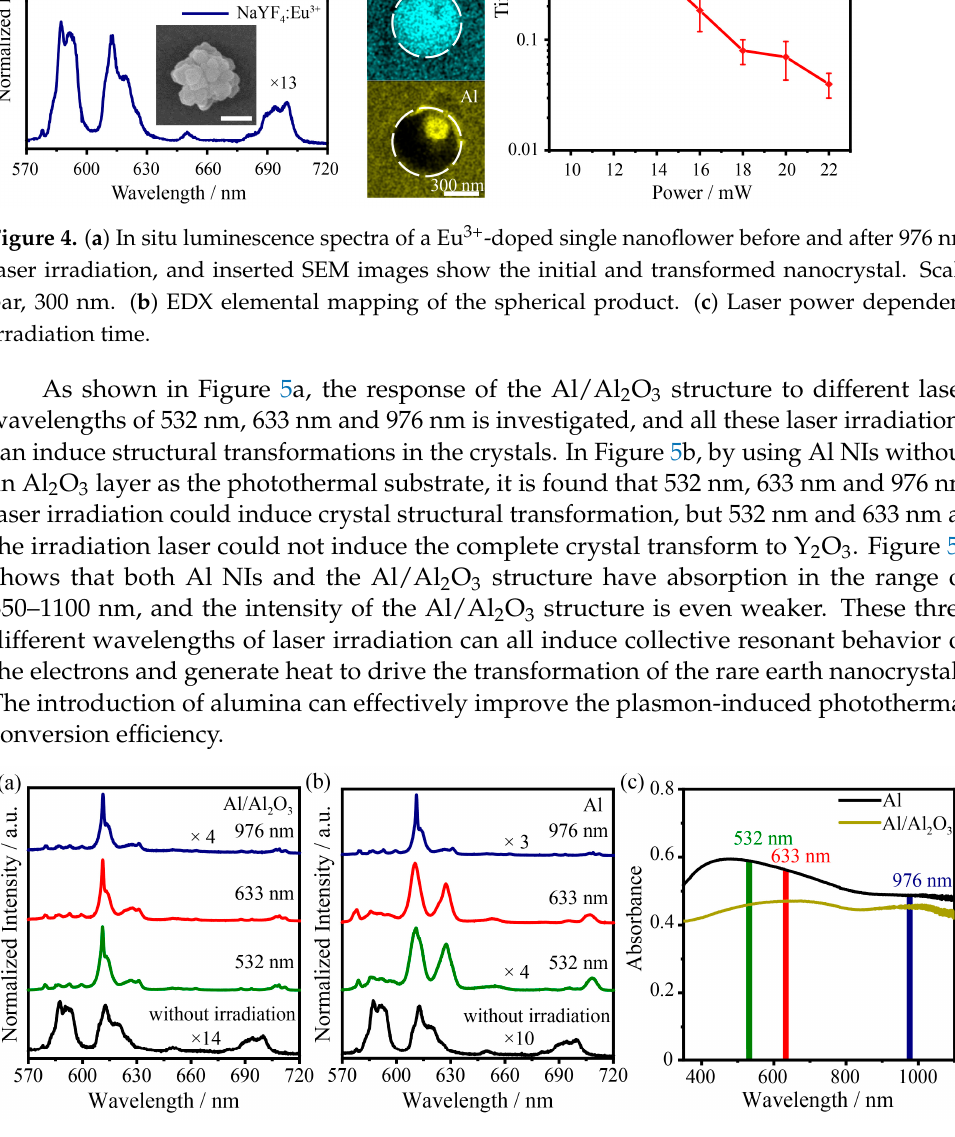
Figure 5. Luminescence spectra of the ( a ) Al/Al 2 O 3 structure and ( b ) Al NIs plasmon driven nanoflower transformation after laser irradiation at 532, 633, and 976 nm. ( c ) UV–Vis spectra of Al NIs and Al/Al 2 O 3